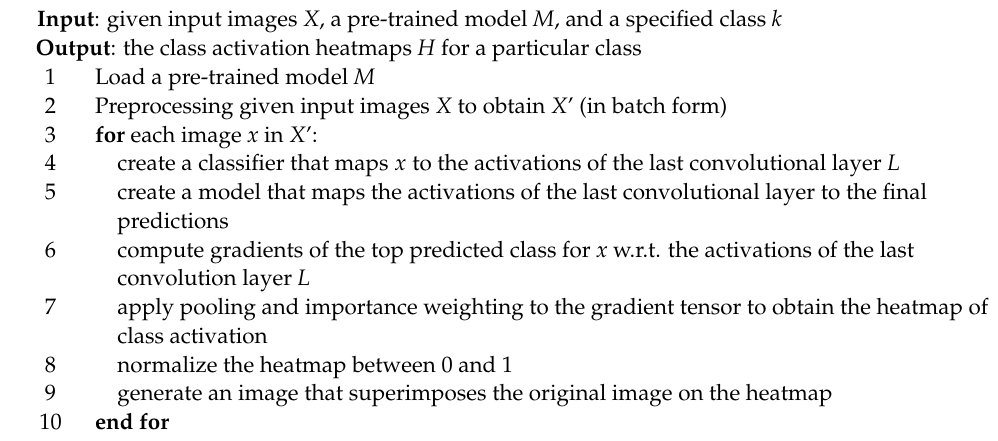
Algorithm 1: Grad-CAM visualization technique for interpreting a CNN